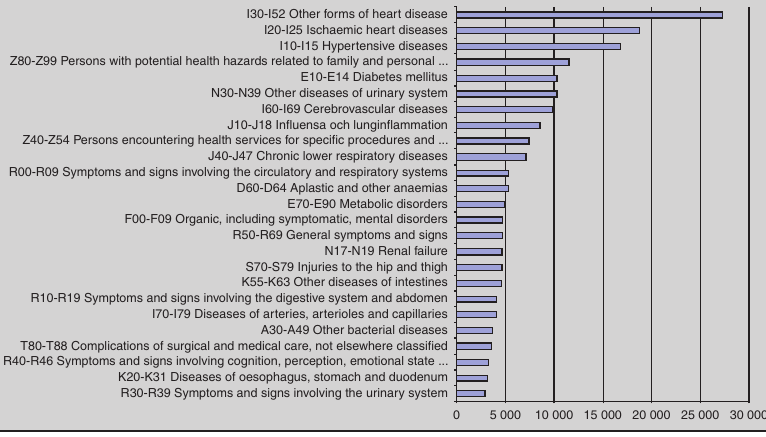
thighN17-N19 Renal intestinesS70-S79 Injuries to the hip and abdomenK55-K63 Other diseases of capillariesR10-R19 Symptoms and signs involving the digestive system and diseasesI70-I79 Diseases of arteries, arterioles and classifiedA30-A49 Other bacterial ...T80-T88 Complications of surgical and medical care, not elsewhere duodenumR40-R46 Symptoms and signs involving cognition, perception, emotional state systemK20-K31 Diseases of oesophagus, stomach and 000R30-R39 Symptoms and signs involving the urinary 0 5 000 10 000 15 000 20 000 25 000 30